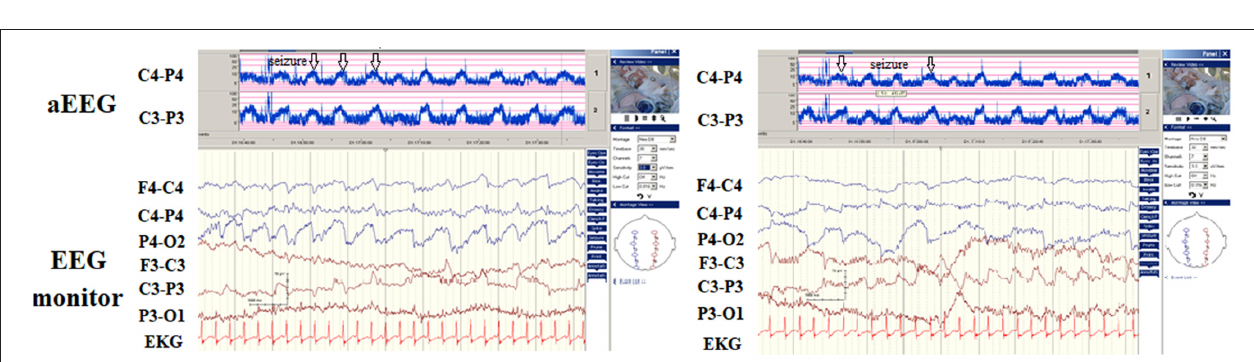
FIGURE 3 | A patient presented with hypoglycemic seizures at neonatal day 2. His seizures did not remit after treatment with several antiepileptic drugs. The automated electroencephalography (aEEG) demonstrated frequent seizures associated with ictal paroxysmal activity on electroencephalography (EEG) monitoring (arrows). She had severe developmental delay at the age of 1 year. The magnetic resonance imaging (MRI) results demonstrated diffuse brain